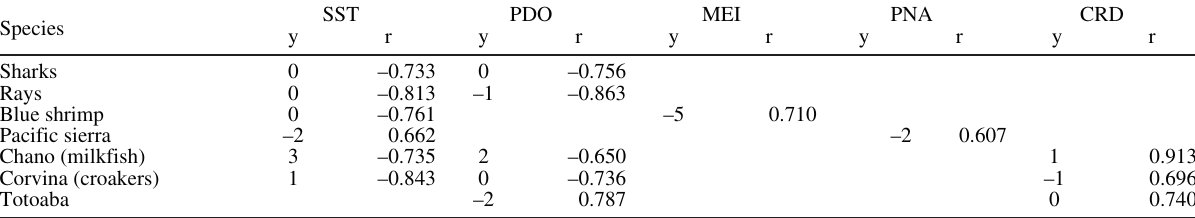
Table 2. – Cross-correlations between the long-term trend components of environmental variability vs. CPUE in the NGC; y, time lag in years; and r, correlation coefficient ( α <0.05). SST PDO MEI PNA Species r y